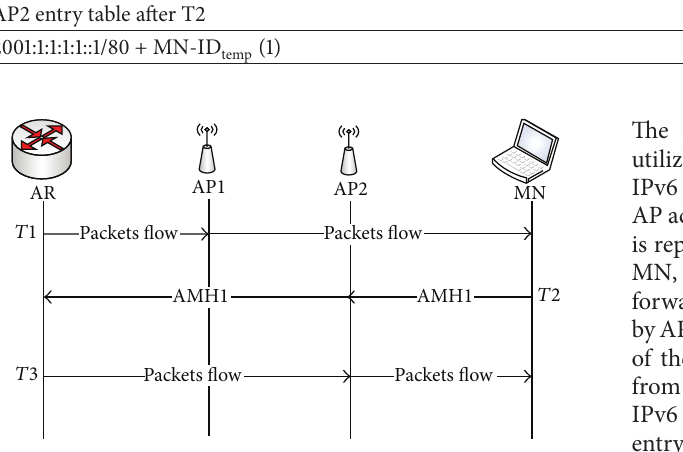
Figure 4: AMH1 scheme within the same